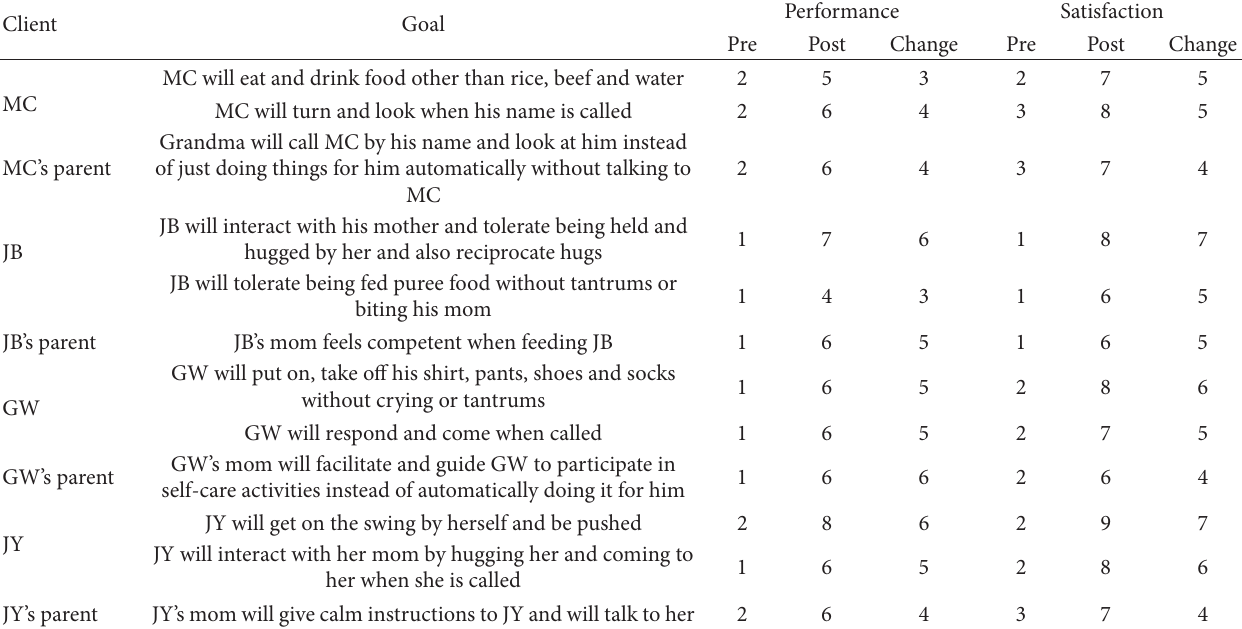
Table 2: COPM Scores for Parent Identified Goals for Themselves and Their